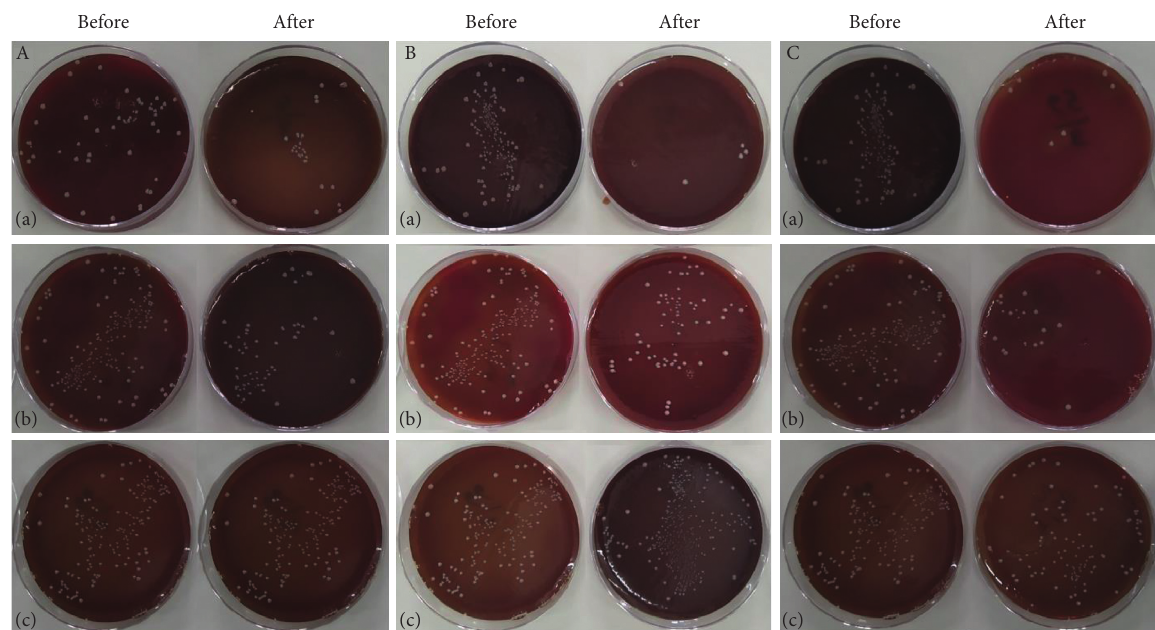
Figure 2: Bacterial culturing before and after irradiation. (a) Er, Cr:YSGG laser, (a) 0.3mm thickness; (b) 0.5mm thickness; and (c) 1mm thickness. (b) 445nm diode laser: (a) 0.3mm thickness; (b) 0.5mm thickness; and (c) 1mm thickness. (c) Er, Cr:YSGG and 445nm diode lasers, (a) 0.3mm thickness; (b) 0.5mm thickness; and (c) 1 mm